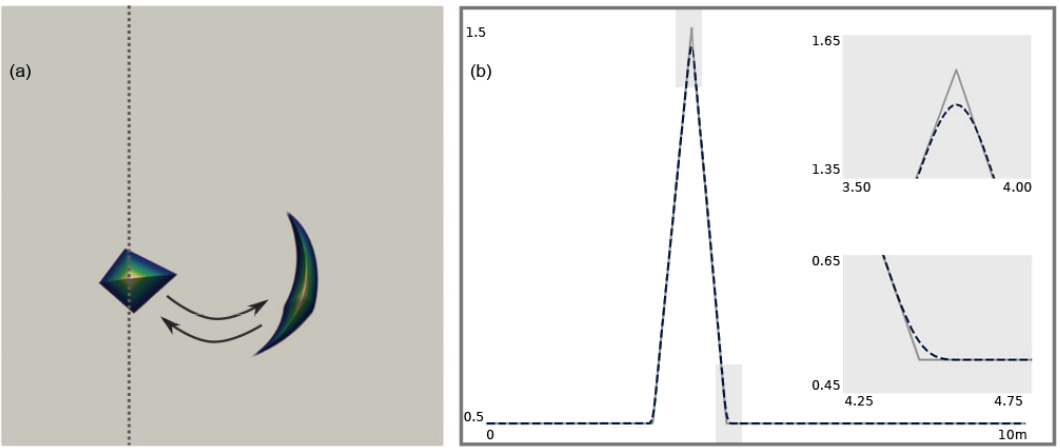
Figure 7. Swirling flow test. Panel (a) shows the top view of simulation results for the 10m × 10m domain at time steps 0 and 0 . 75s. The dashed vertical line indicates the location of the respective profiles of the simulation results (dashed blue line) and the analytical solution (grey line) at the final time step of 1 . 5s shown in (b) . The two small inserts show zooms of the grey rectangles on the main